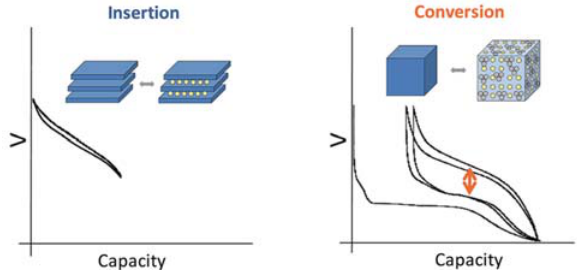
Figure 3 . Schematic representation and typical potential vs. capa- city profile for conventional insertion and alternative conversion reaction pathways in lithium-ion battery electrodes. (Reprinted from 18 with permission)